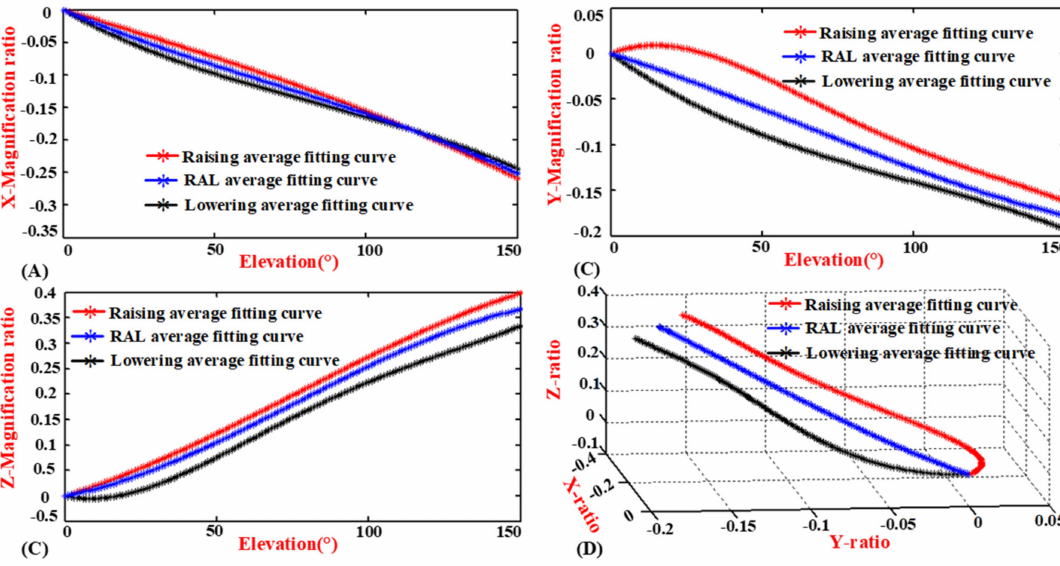
Figure 12. Comparison of the Motion Coupling Characteristics in Di ff erent Phases. ( A ) X -direction magnification ratio and humeral elevation angle. ( B ) Y -direction magnification ratio and humeral elevation angle. ( C ) Z -direction magnification ratio and humeral elevation angle. ( D ) X , Y , and Z -directions magnification